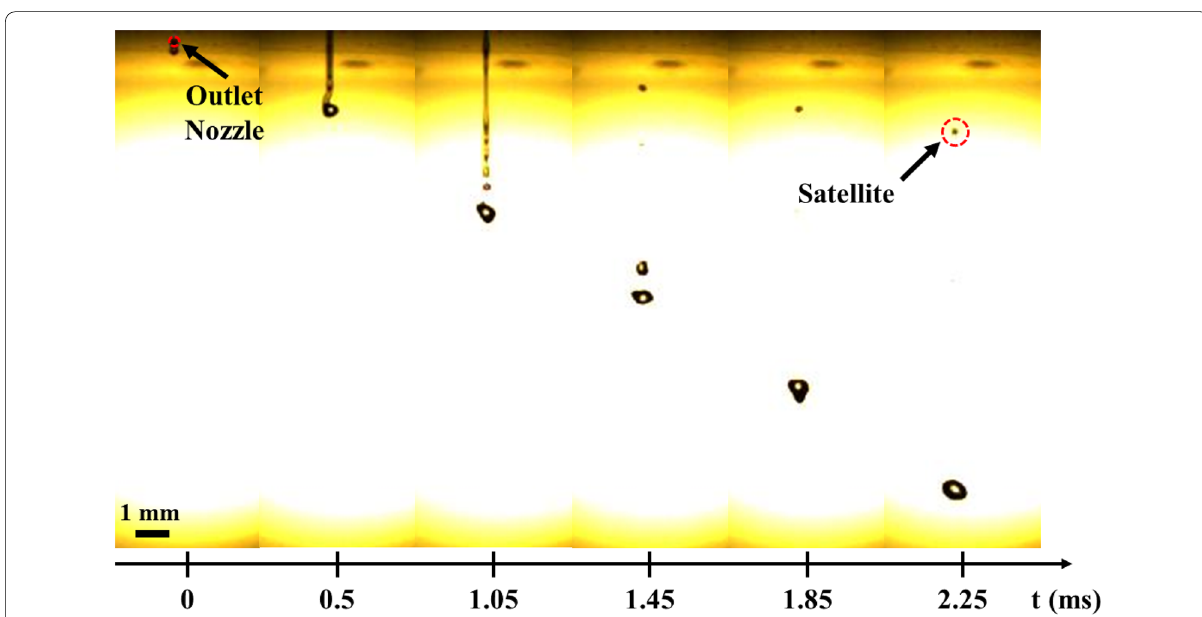
Fig. 6 Sequential images of ejected droplet (nozzle diameter ~ 200